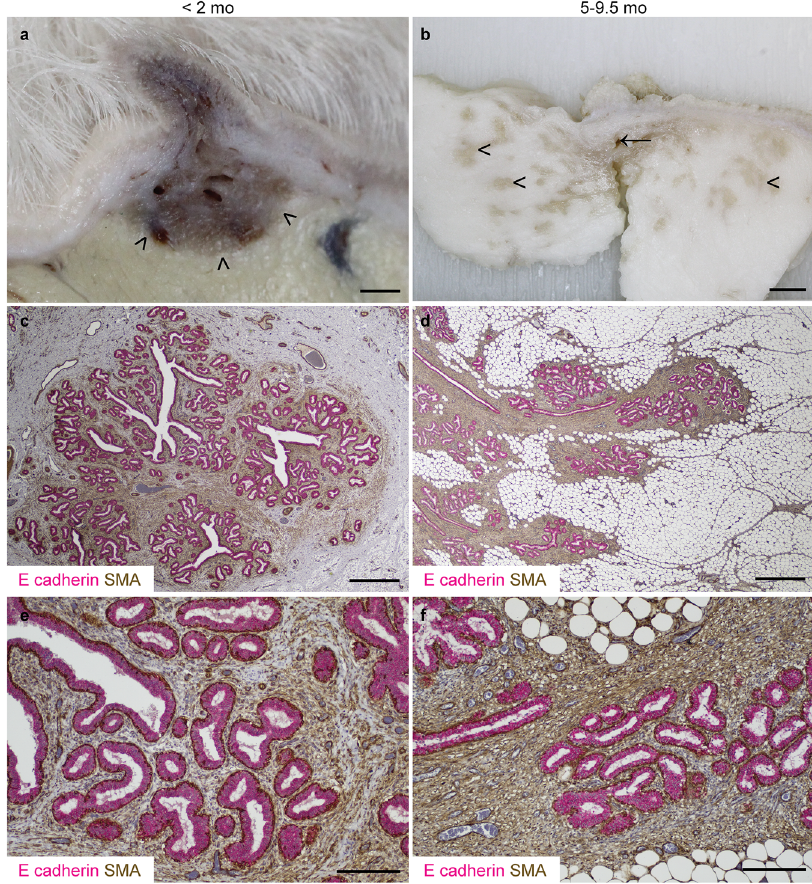
Fig. 1 Lamb terminal duct lobular units (TDLUs) advance into the mammary fat pad during postnatal development. a , b Sub-gross images of fi xed mammary tissue. Arrowheads indicate the developing mammary TDLUs in fi ltrating the mammary fat pad. Arrow indicates rudimentary gland cistern. c – f Immunohistochemical staining for E-cadherin (magenta) & alpha-smooth muscle actin (SMA; brown). Haematoxylin counterstain. Bar: 1.5 mm ( a ); 5 mm ( b ); 800 μ m ( c , d ); 200 μ m ( e , f ). Images are representative of fi ve biological